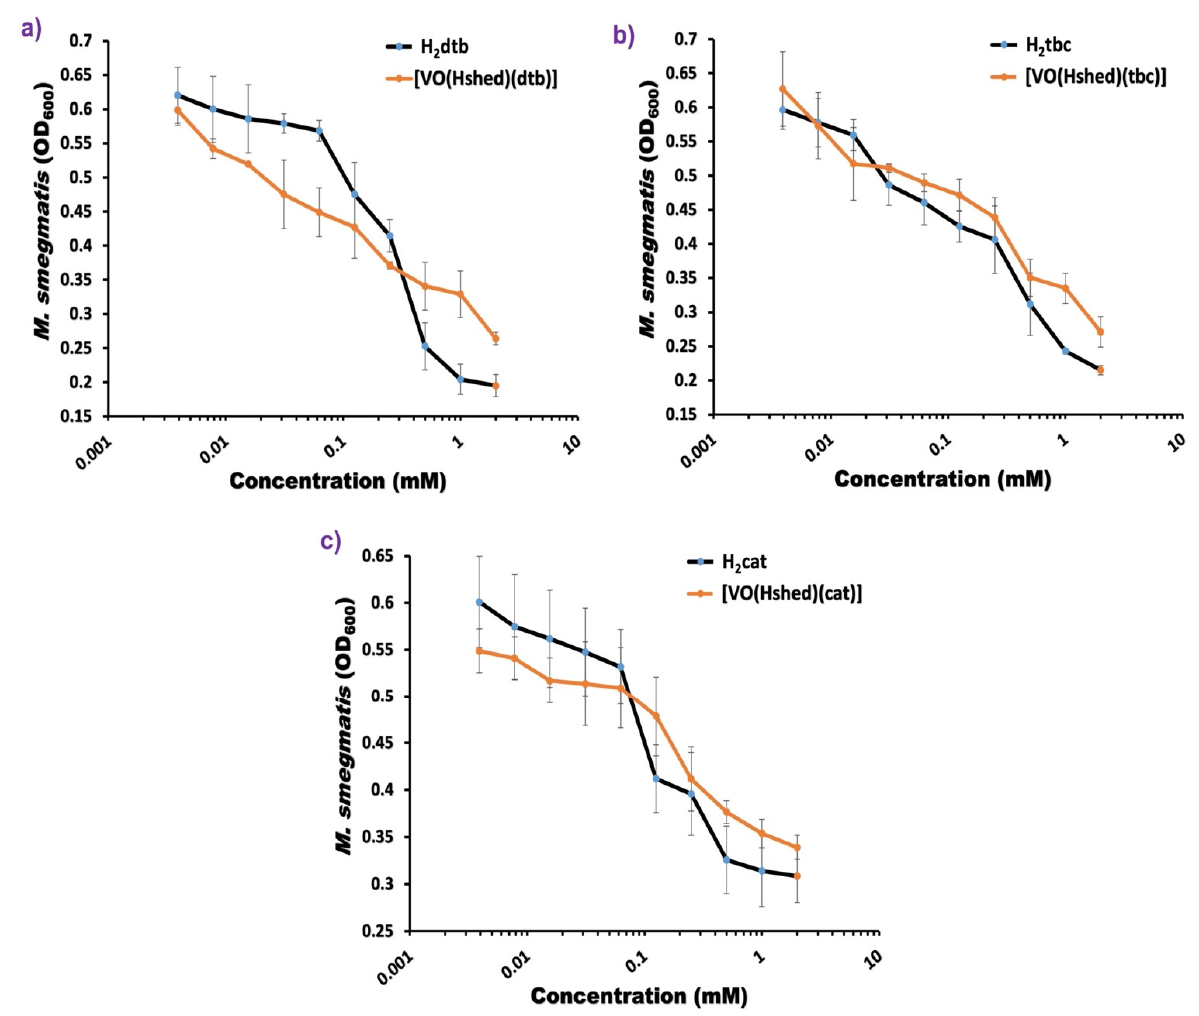
Figure 3. Histograms showing the growth of M. smeg treated with ( a ) [VO(Hshed)(dtb)] and H 2 dtb, ( b ) [VO(Hshed)(tbc)] and H 2 tbc, and ( c ) [VO(Hshed)(cat)] and H 2 cat using concentrations ranging from 0.004 to 2.00 mM. Error bars are the standard deviation for triplicate measurements. The IC 50 values of V-complexes and their free ligands are shown in Table 2. Alt- hough all of the V-complexes and their free ligands were comparatively weak growth inhibitors of M. smeg, differences in growth inhibition were observed between the V- complex and its free ligand. The IC 50 of [VO(Hshed)(dtb)], [VO(Hshed)(Coum)], and [VO(Hshed)(4NO 2 )] indicated that these compounds were more potent in inhibiting bac- terial growth with an IC 50 of 119, 370, and 472 μ M, respectively. In complexes, their lig- ands showed 2-, 1.4-, and 1.3-fold more growth inhibition than did the free ligands. [VO(Hshed)(cat)], [VO(Hshed)(3OMet)], and [VO(Hshed)(CN)] showed less inhibitory activity against the bacterial growth with an IC 50 of 518, 555, and 608 μ M, respectively, when compared with their free ligands. Finally, the IC 50 of [VO(Hshed)(tbc)] had a simi-